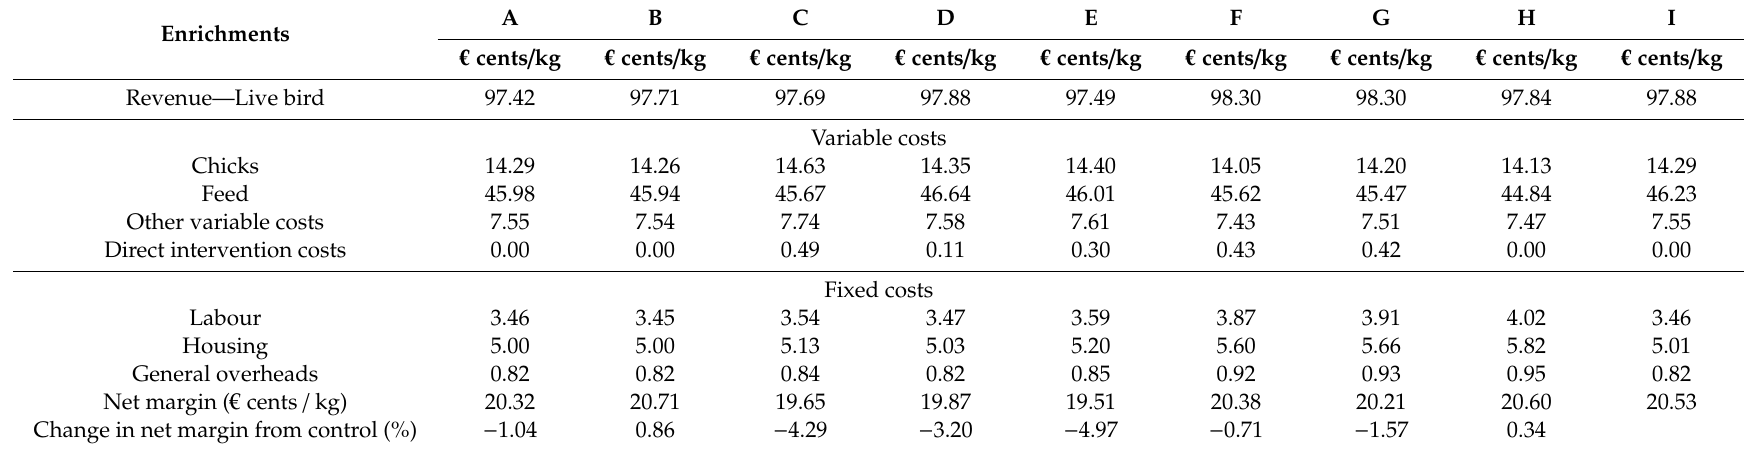
Change in net margin from control